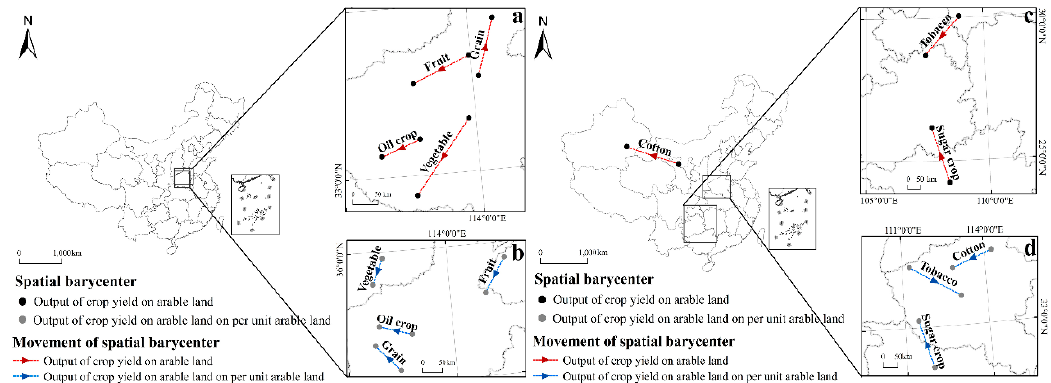
Figure 11. The movement of the spatial barycenter for the outputs on arable land.